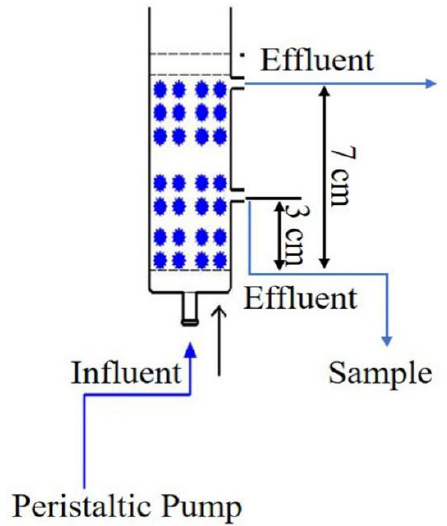
Figure 1. The experimental device of column adsorption.